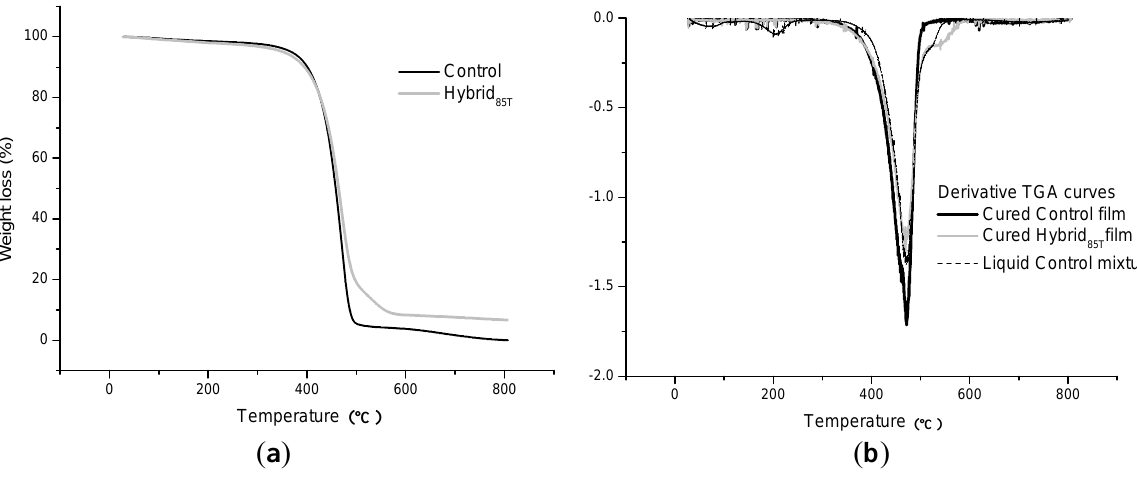
systems; and 85T 85T